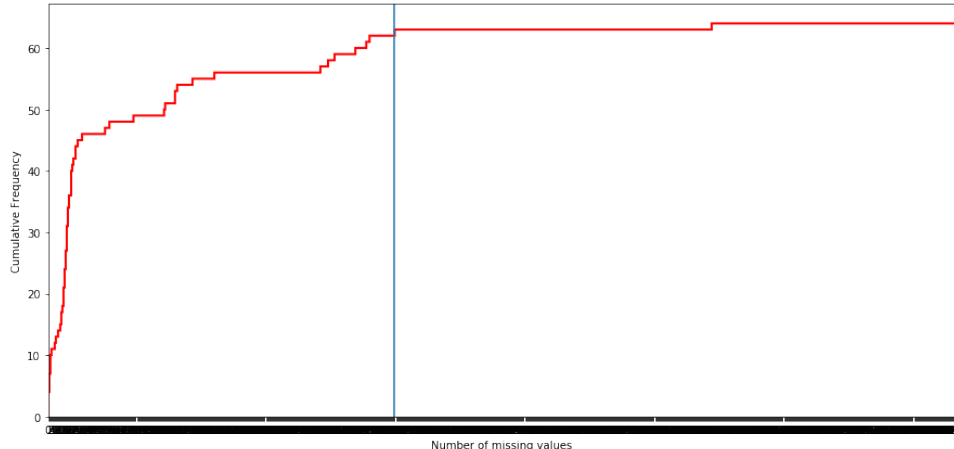
Figure 3. Cumulative histogram of the number of missing values by features.